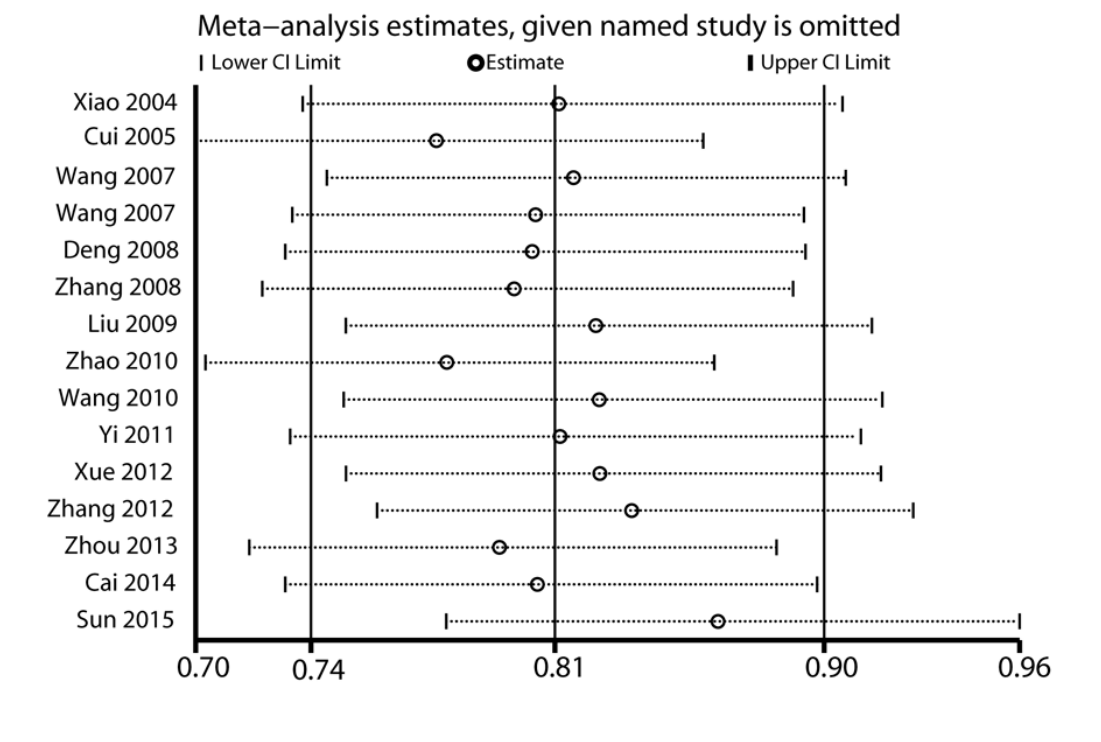
Figure 3: Sensitivity analysis for the association between ABCA1 R219K and ischemic stroke for the included